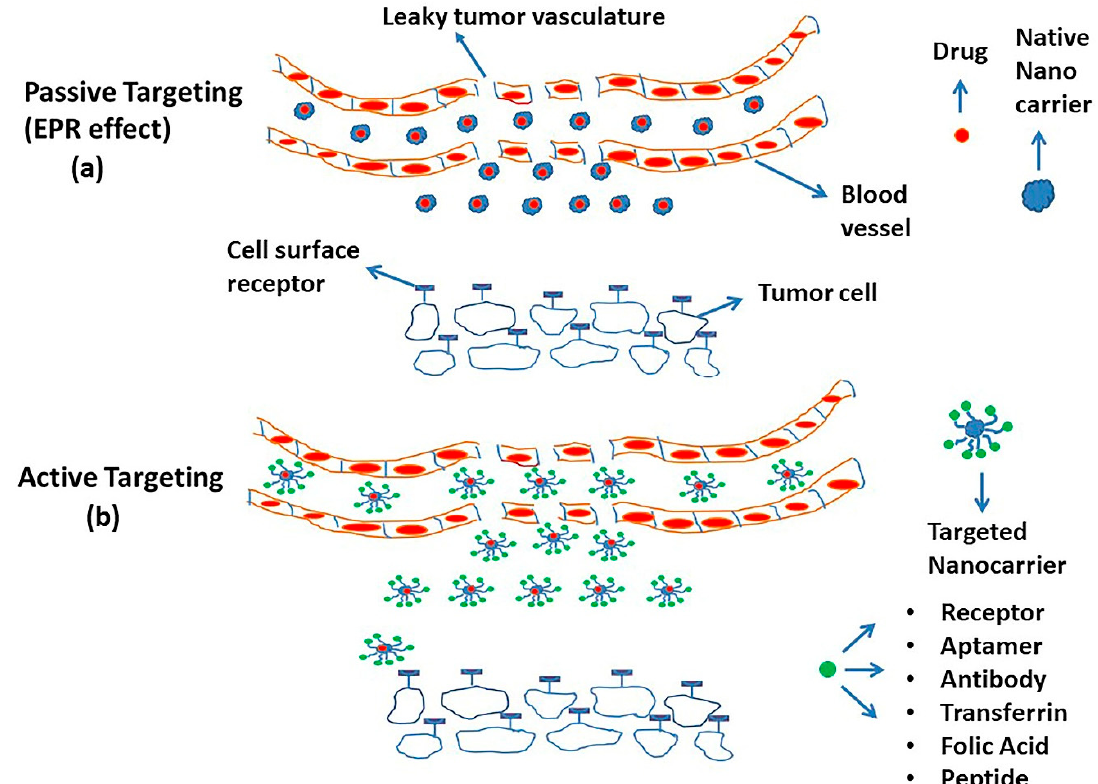
Figure 4. The figure shows passive (enhanced permeability and retention (EPR) effect) ( a ) and active tumor targeting ( b ) of nanoparticles (NPs) for targeted drug delivery. Tumors have disorganized and leaky vasculature with a higher number of pores facilitating the movement of NPs from the vasculature and their accumulation in the tumor environment. Moreover, active targeting makes use of targeting ligands that are attached to NPs and bind specifically to cell surface receptors of tumor cells.